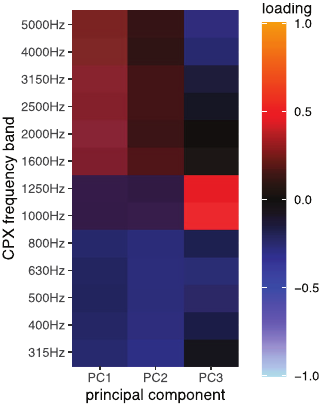
Figure 1. Loading vectors of the fi rst three principal compo- nents of the CPX one-third octave band PCA, the loading strength is color-encoded.